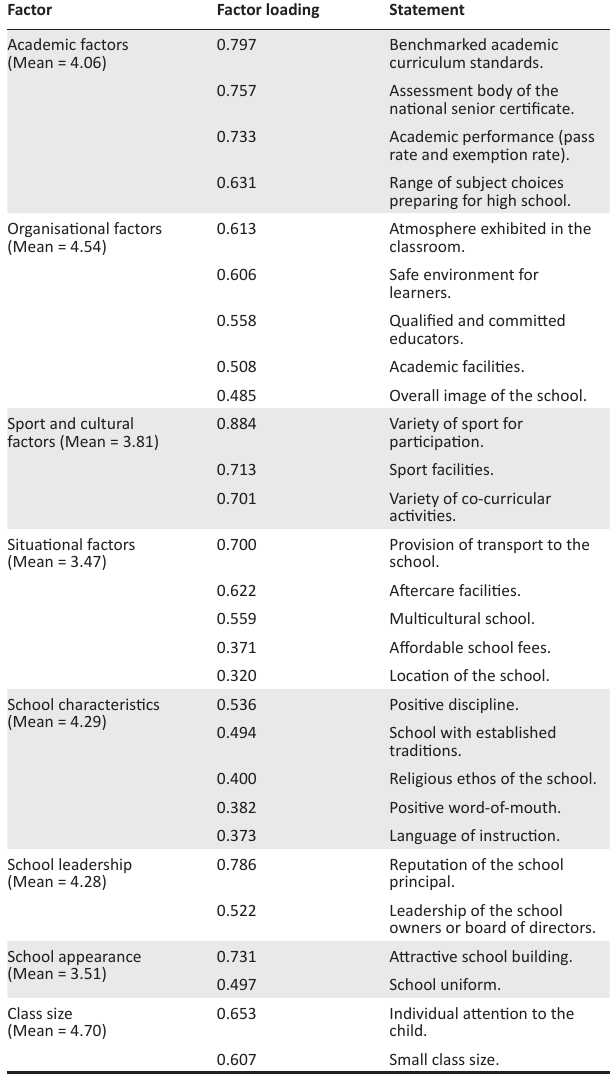
TABLE 4: Choice factors identified.